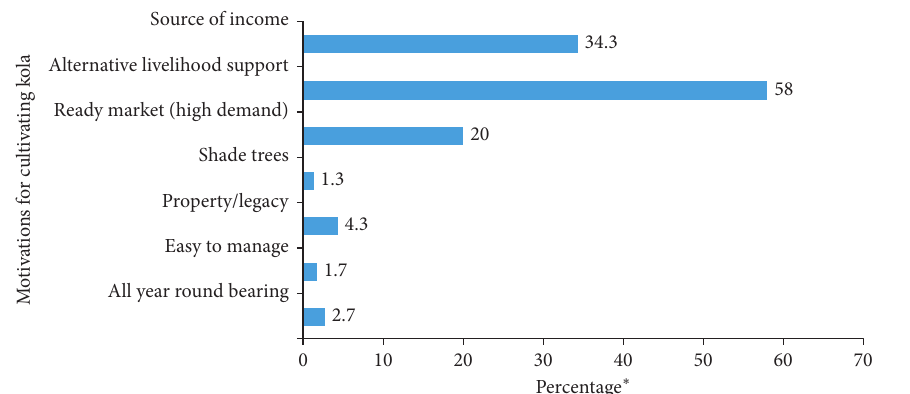
Figure 8: Motivation factors for the cultivation of kola ( ∗ multiple